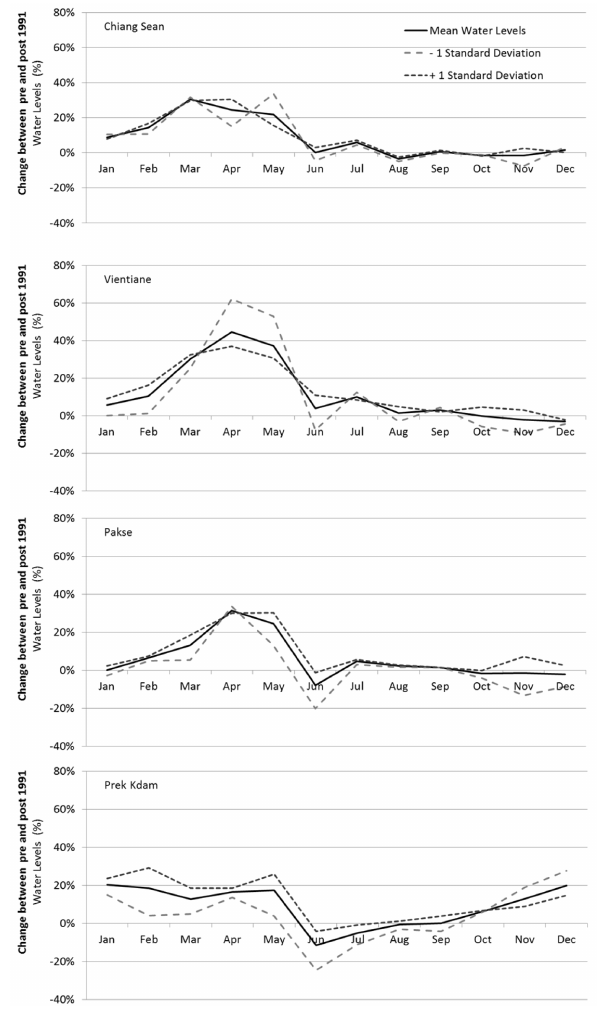
Figure 5. Change (%) in average mean ± 1 standard deviation for each month between pre- and post-1991 water levels for Chiang Saen, Vientiane, Pakse, and Prek Kdam.